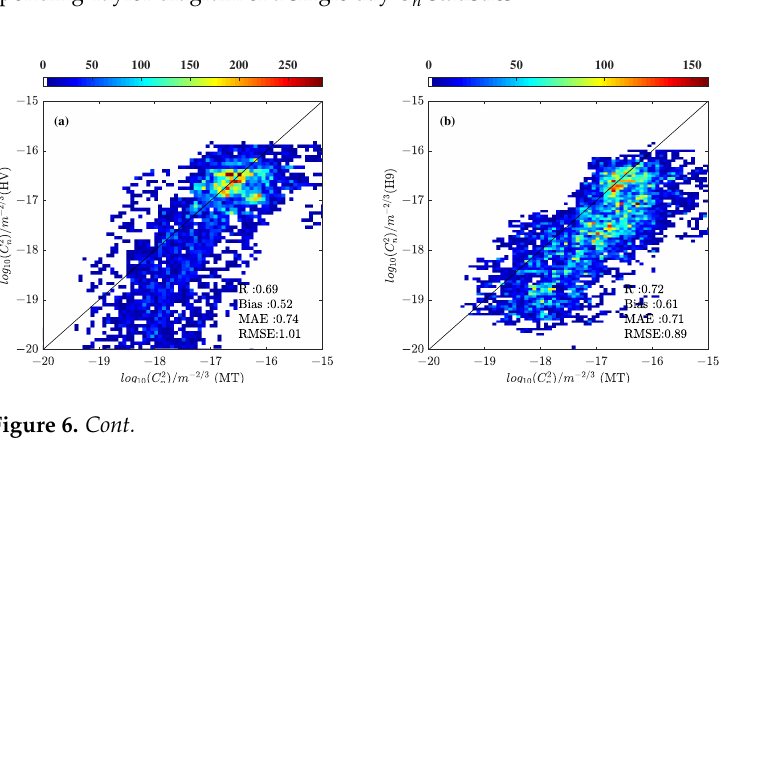
Figure 5. Measured and estimated C 2 n profiles in NCACN. ( a , b ) A single day C 2 n profiles; ( c , d ) corre- sponding Taylor diagram of a single day C 2 n statistics.